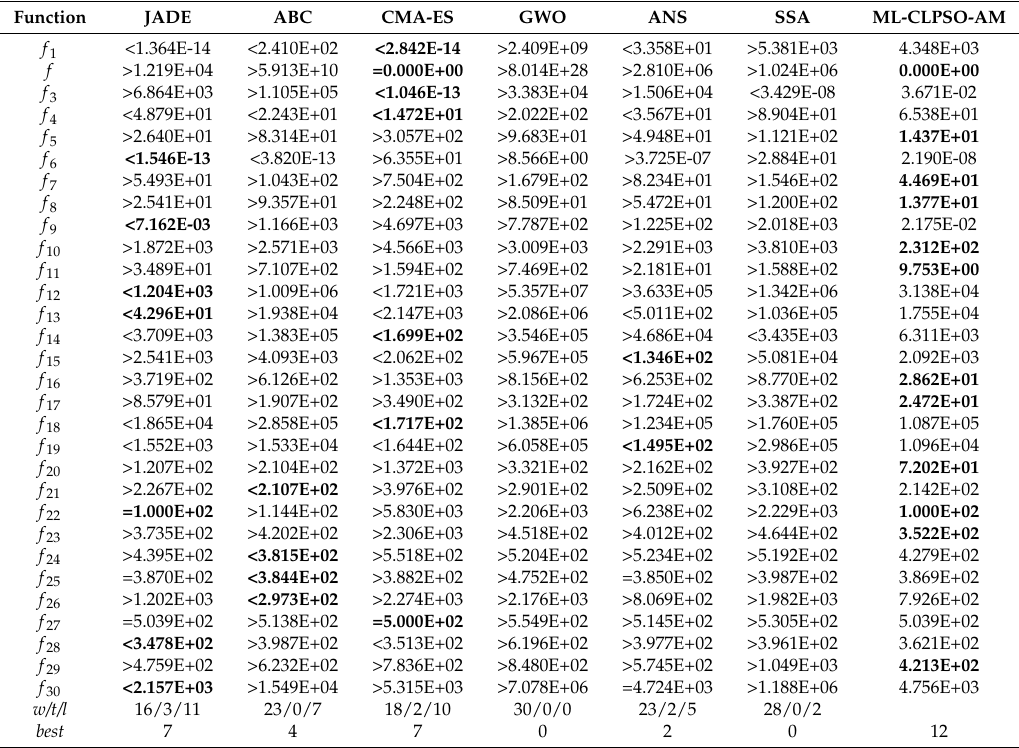
Table 5. Comparison test results with EAs and